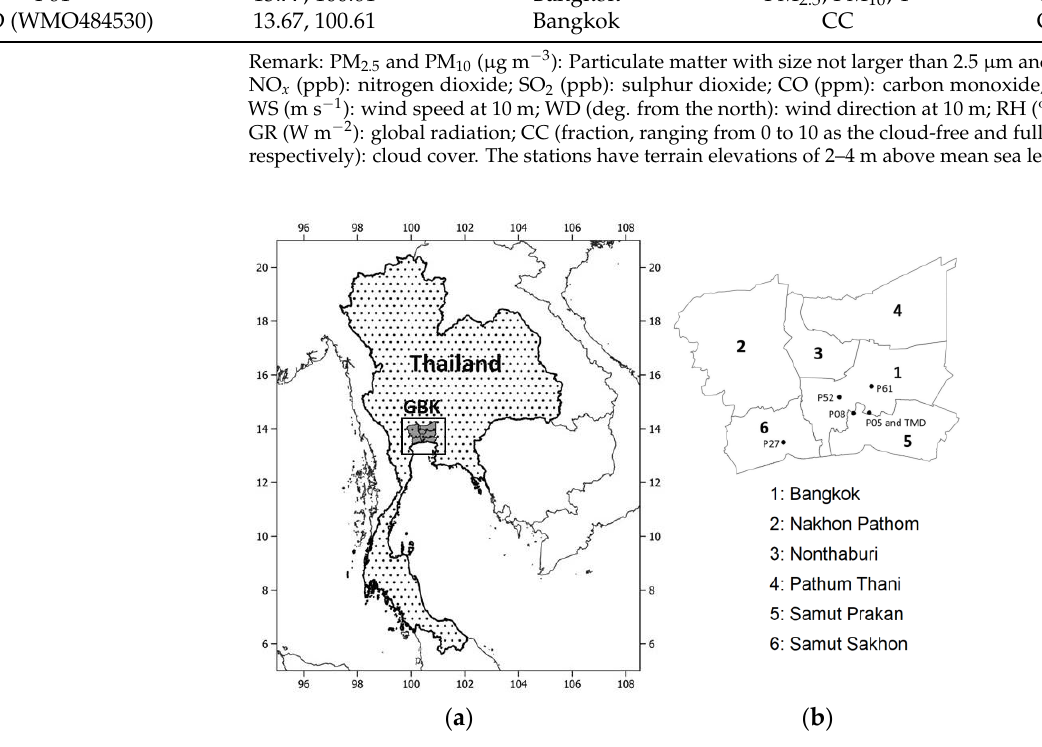
Table 1. Surface stations and variables used in the